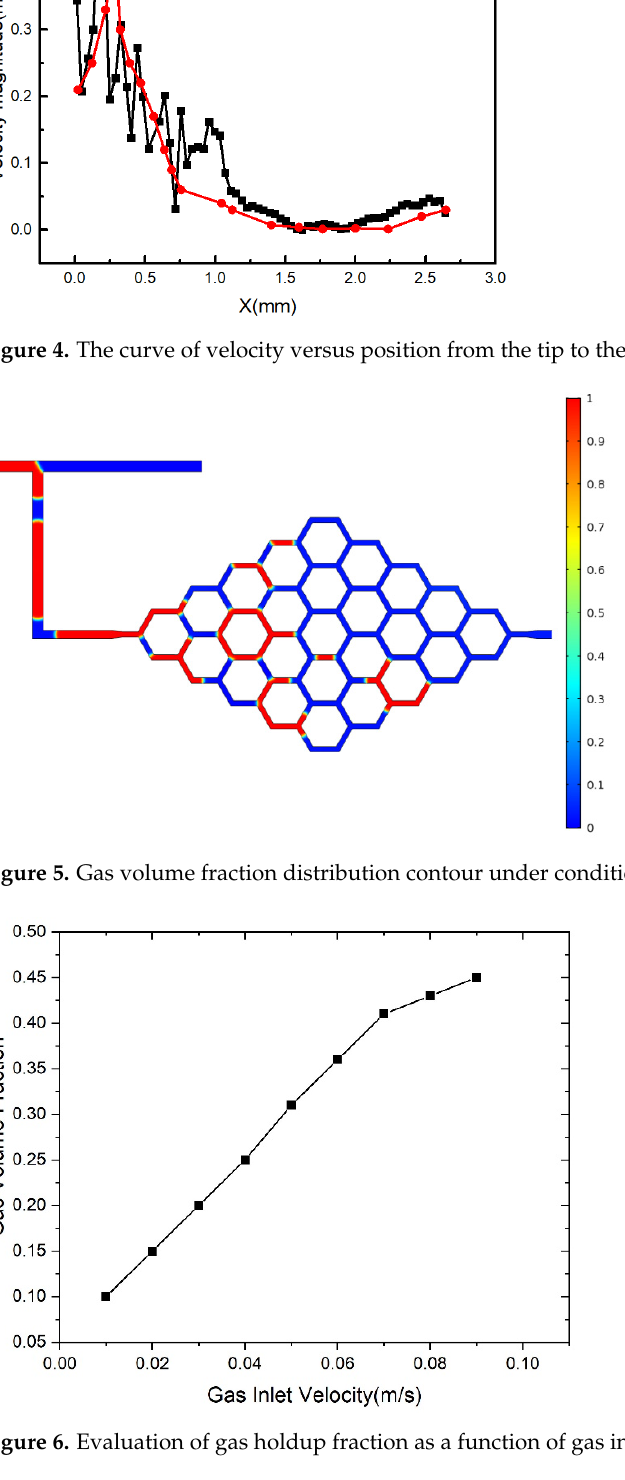
Figure 6. Evaluation of gas holdup fraction as a function of gas inlet velocity.